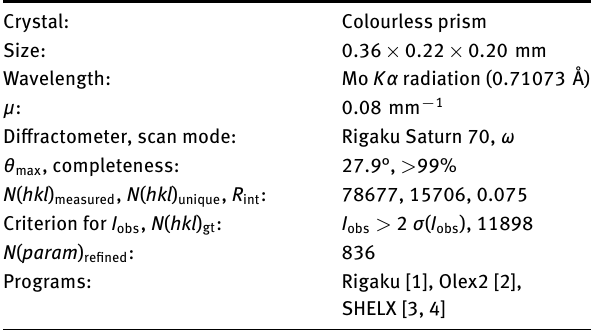
Table 1: Data collection and